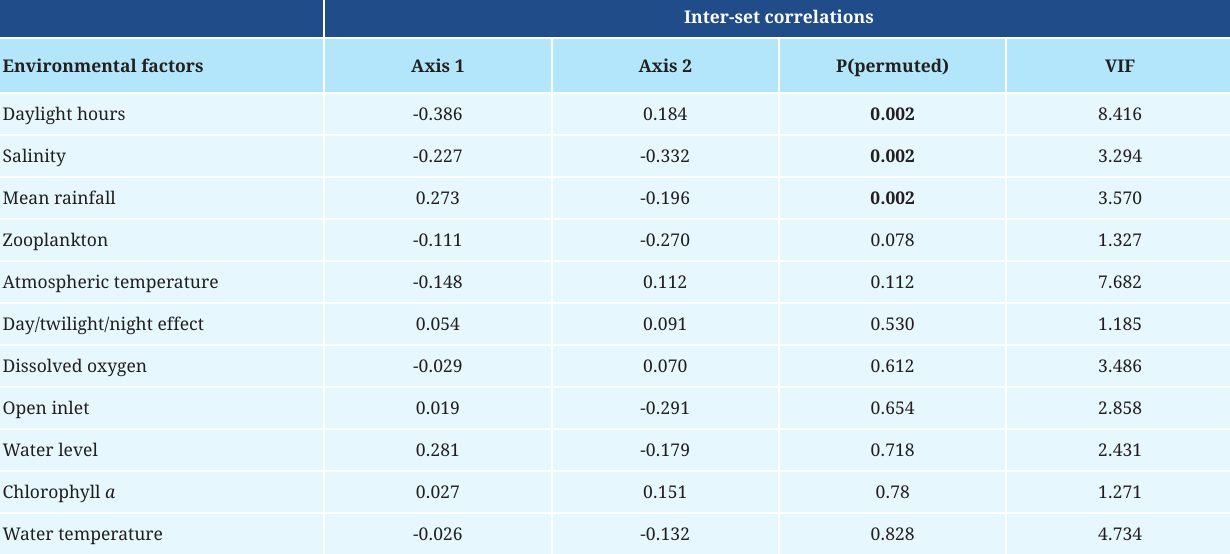
TABLE 4 | Inter-set correlations between environmental factors and species scores, significance of these factors (unrestricted Monte Carlo permutations), and variance inflation factors (VIF), from Canonical Correspondence Analysis. Significant P values are shown in